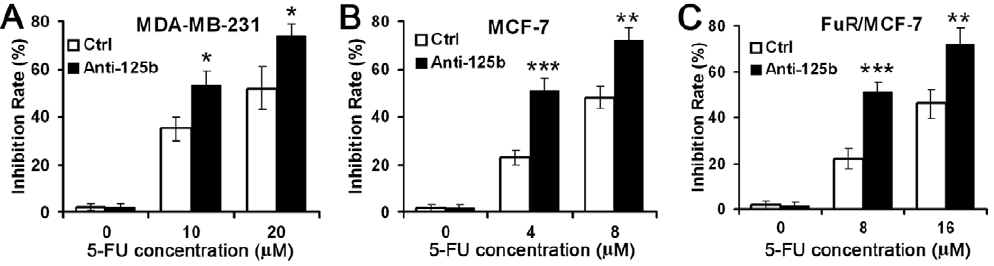
Figure 5. Knockdown of miR-125b sensitized breast cancer cells to chemotherapy. MDA-MB-231 (A), MCF-7 and 5-FU resistant FuR/MCF-7 (B) cells were transfected with 100 nM anti-miR-125b or anti-scramble control (Ctrl). Then the cells were treated with the indicated concentrations of